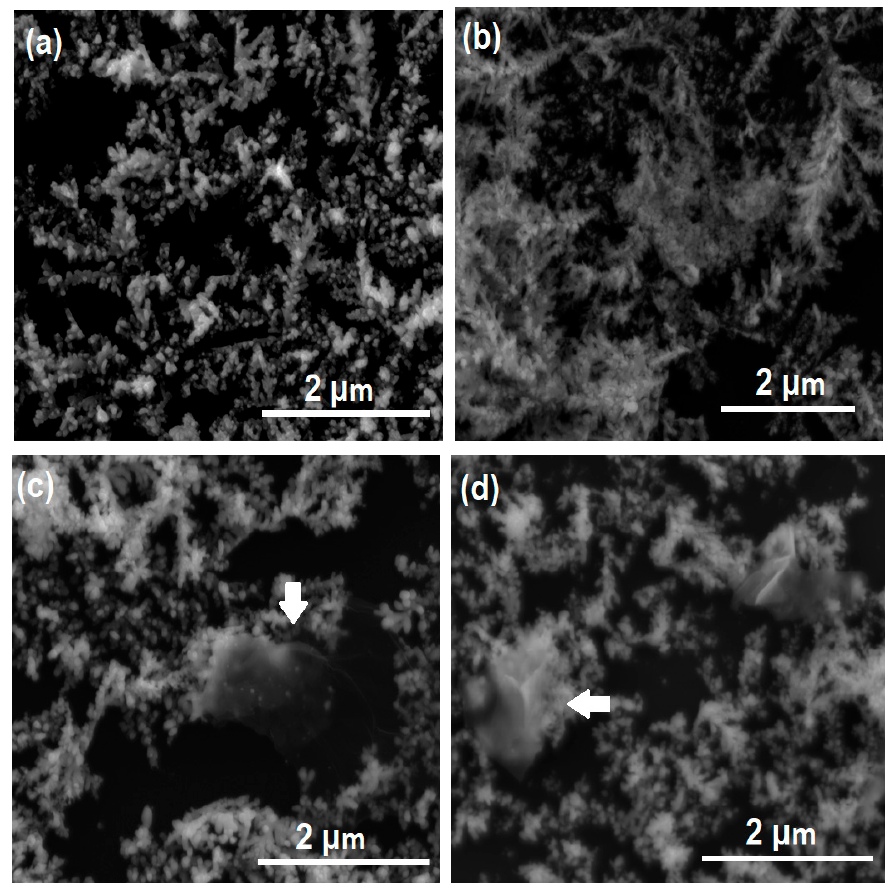
Figure 4. Typical SEM images of different G-SERS substrates. ( a ) Uncoated silver dendrites (N = 0). ( b ) GO-coated dendrites (N = 25). ( c ) rGO-coated dendrites (N = 5). ( d ) GNP-coated dendrites (N = 1). The white arrows indicate visible graphene-based coatings on the dendrites.